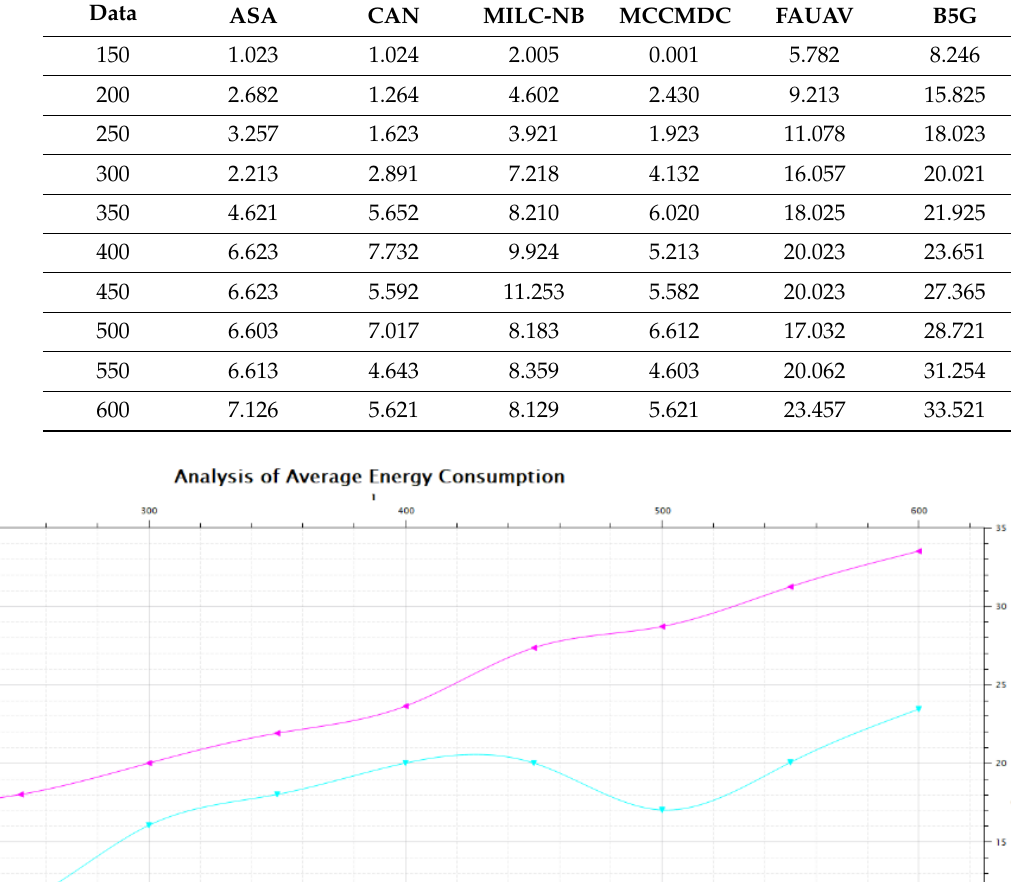
Table 2. Analysis of Average Energy Consumption.